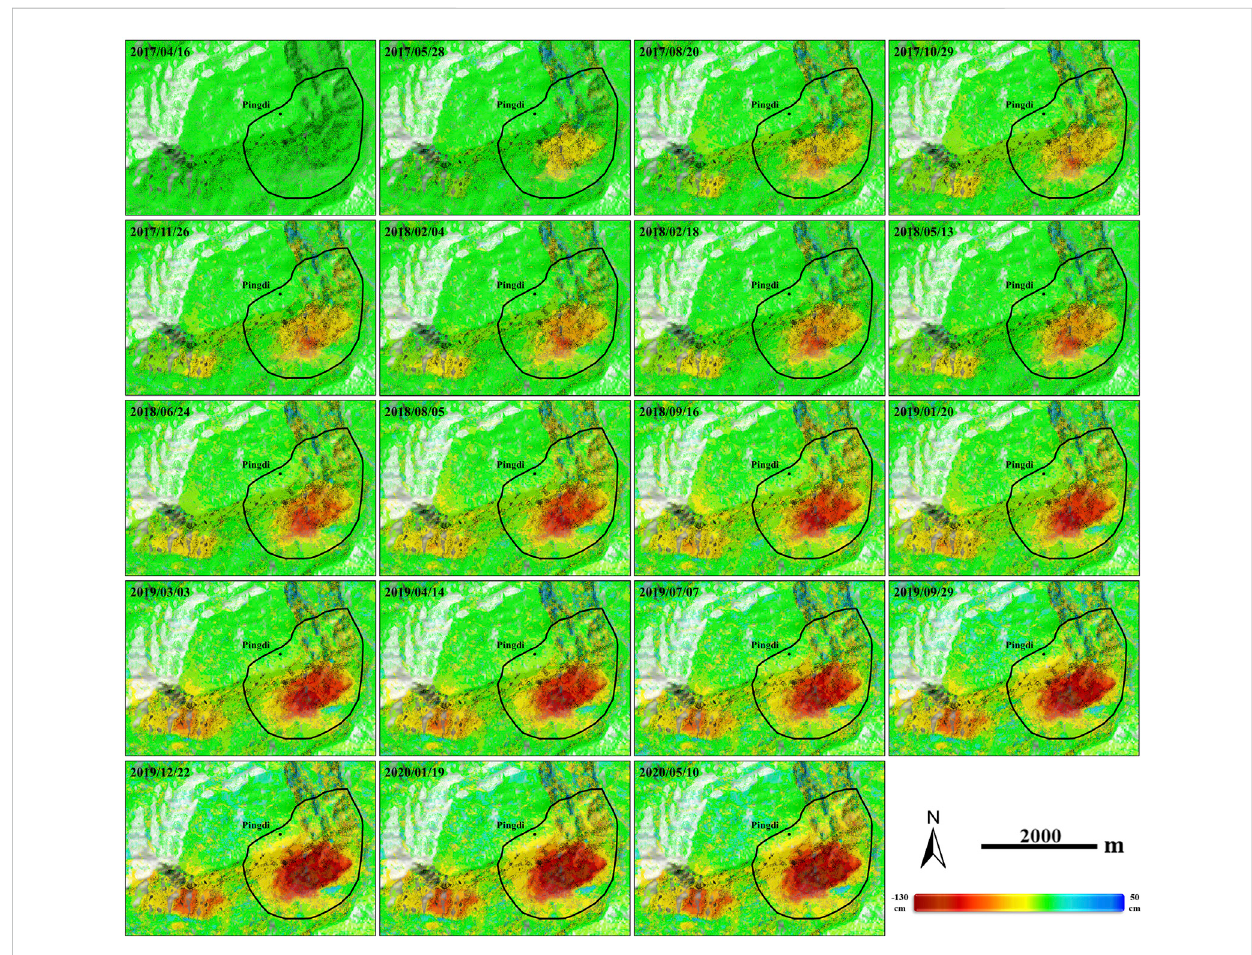
FIGURE 9 The cumulative deformation time series of the Pingdi landslide in the LOS direction from 16 April 2017, to 10 May 2020, where the solid polygons indicate the boundaries of Pingdi